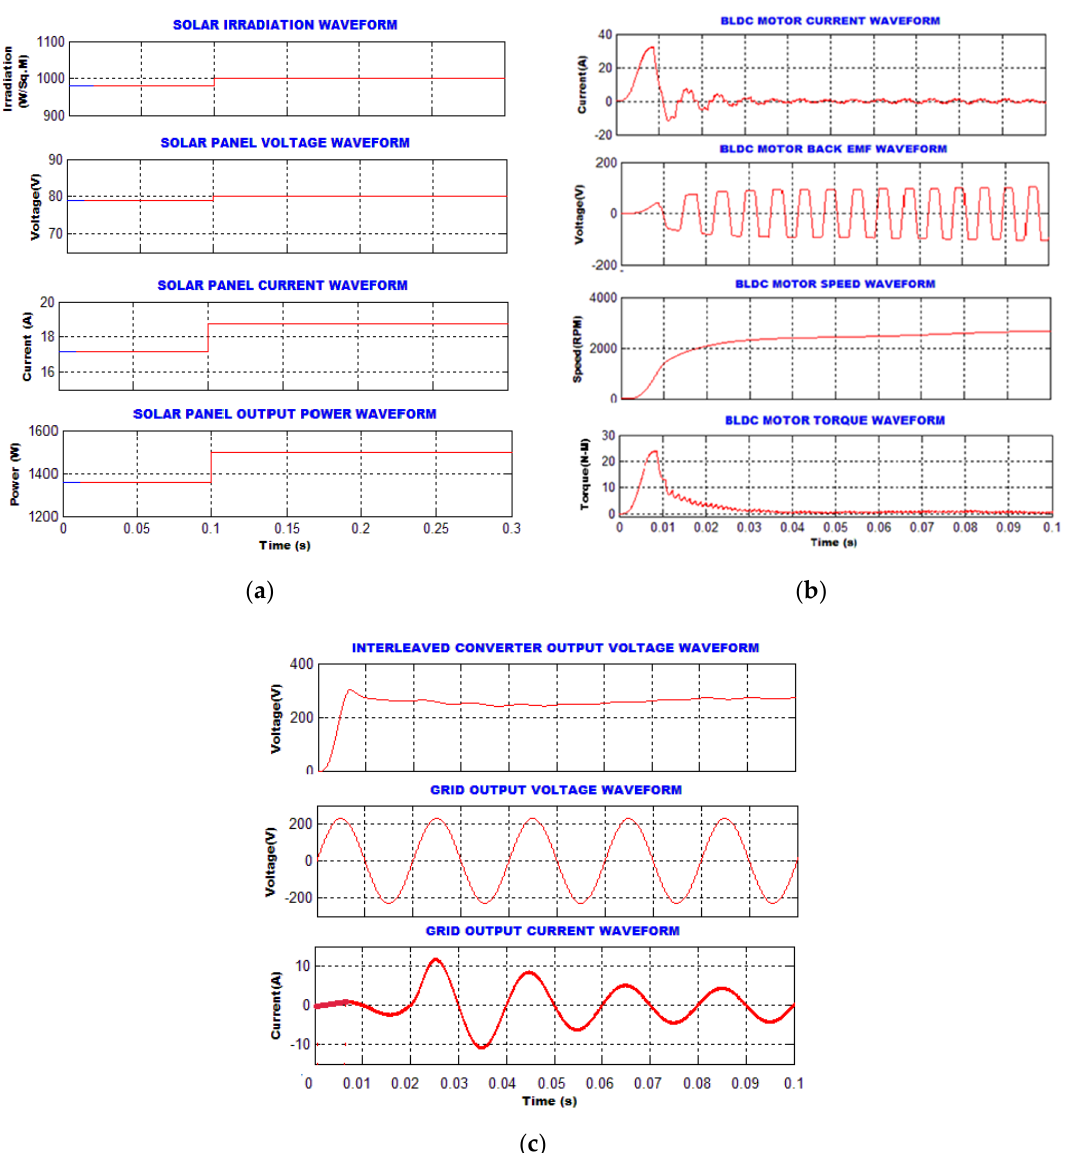
Figure 7. Electrical performance parameters: ( a ) solar photovoltaic array; ( b ) the brushless direct current motor; ( c ) interleaved Luo converter and grid.